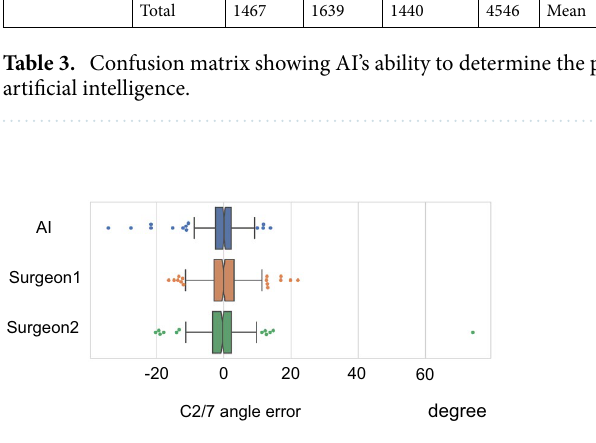
Figure 6. Box plot of the errors at the C2–C7 angle for 168 randomly selected participants with a total of 415 x-rays. The top of the box represents the 75th percentile, the bottom of the box represents the 25th percentile, and the line in the middle represents the 50th percentile. The whiskers represent the highest and lowest values that are not outliers or extreme values. Dots beyond the whiskers represent outliers and extreme values. AI, artificial intelligence.